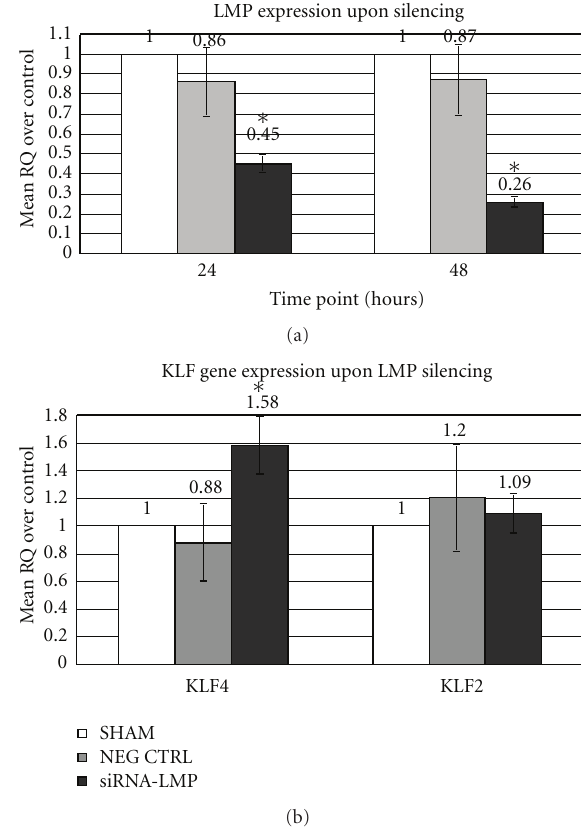
Figure 5: Gene expression analysis upon LMP silencing. The histogram represents the relative expression levels of LMP (24 and 48 hours following siRNA transfection, (a)), KLF2 and KLF4 (24 hours after LMP silencing, (b)). Values represent the mean of triplicate experiments for each test. SHAM: cells treated with transfection reagent alone; Neg Ctrl: cells transfected with AllStars Negative Control SiRNA; SiRNA-LMP: cells treated with SiRNA- LMP construct; RQ: relative quantity, calculated according to 2 − ΔΔ Ct method; ∗ : statistically significant ( P < 0 .